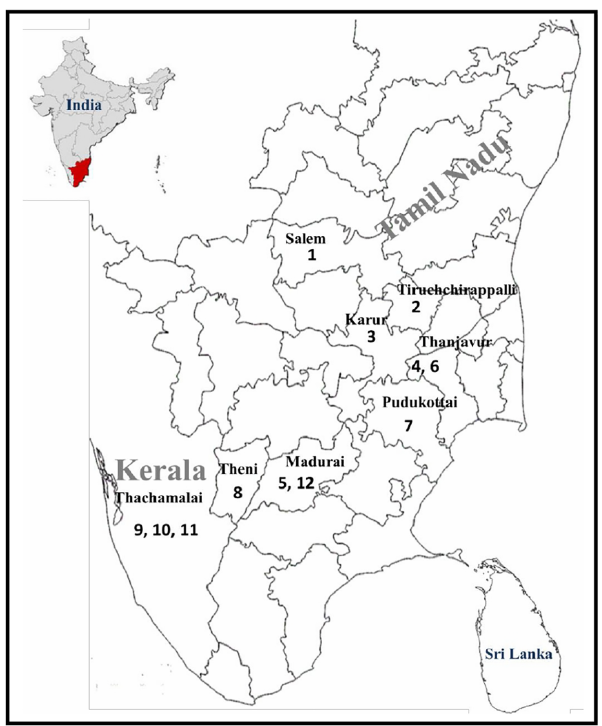
Fig 1. Map showing study areas of caste and tribal populations. (1) Vanniyar (n = 51); (2) Pallar (n = 50); (3) Vettuva Gounder (n = 44); (4) Kallar (n = 53); (5) Iyer (n = 44); (6) Sourashtra (n = 39); (7) Narikuravar (n = 58); (8) Paliyar (n = 58); (9) Namboothiri (n = 35); (10) Nair (n = 56); (11) Kani (n = 49); (12) Yadava (n =